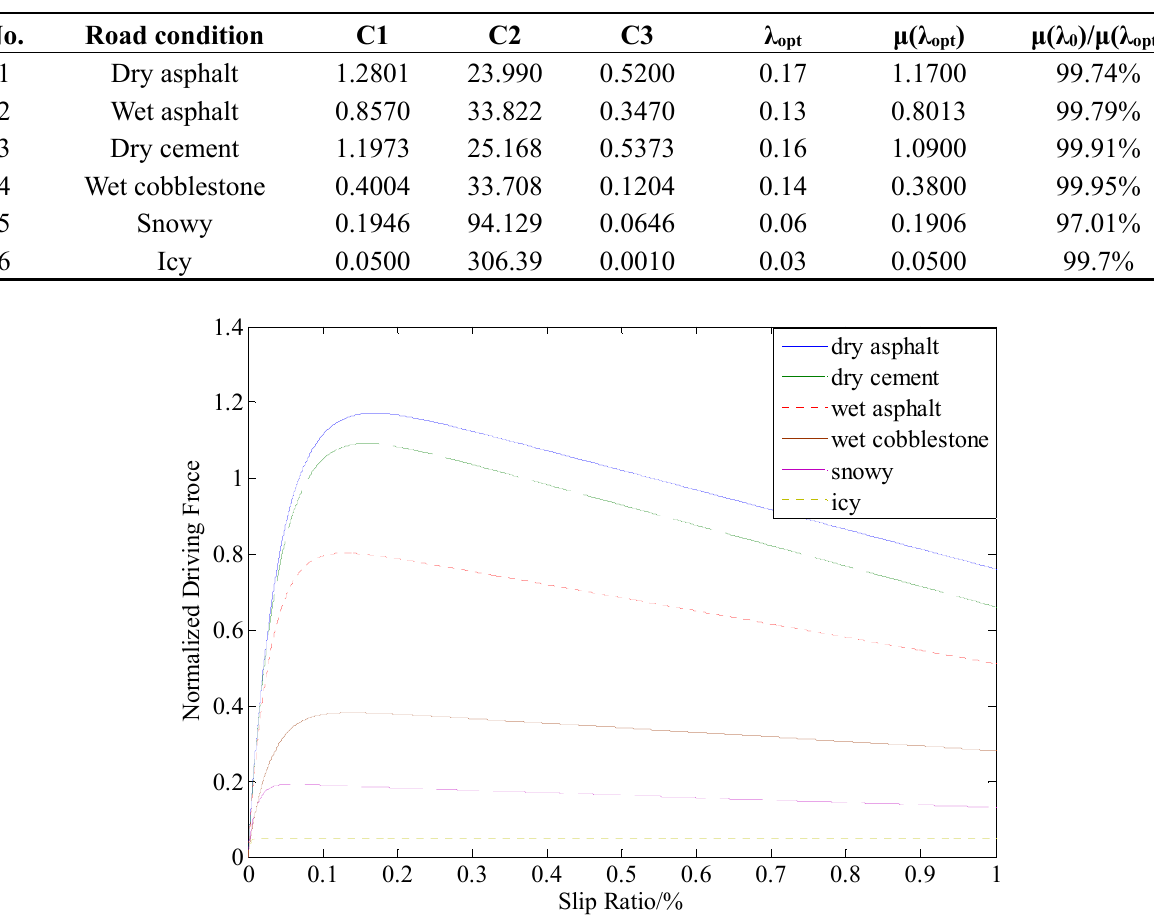
Table 3. Fitting coefficients and parameters of Burckhardt Model.